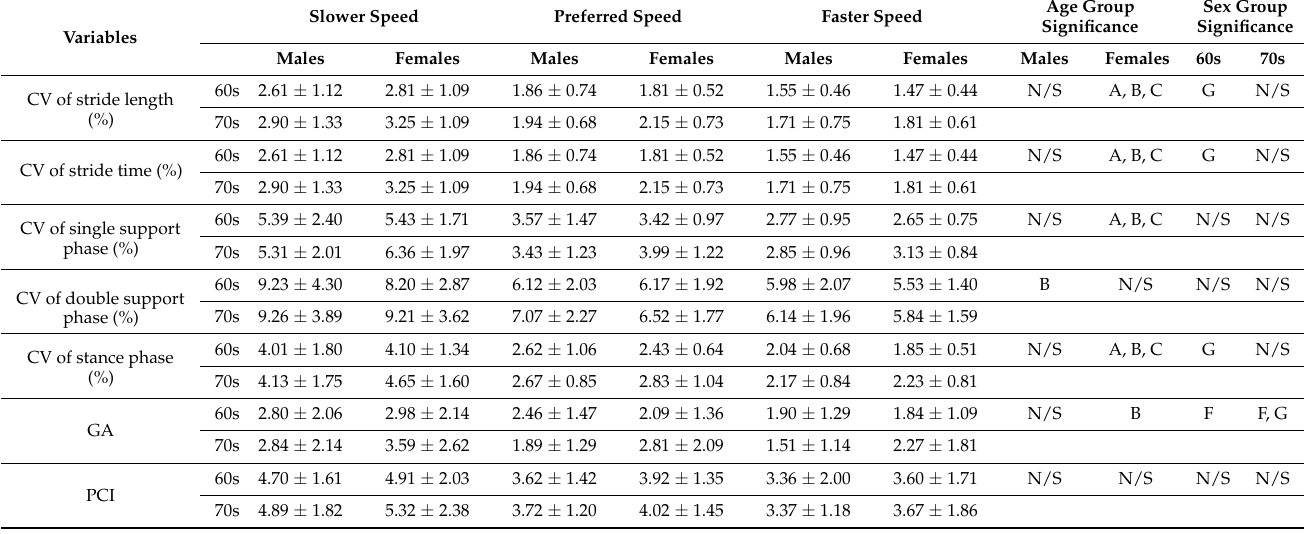
Table 2. Comparison of gait variability characteristics by age and sex.